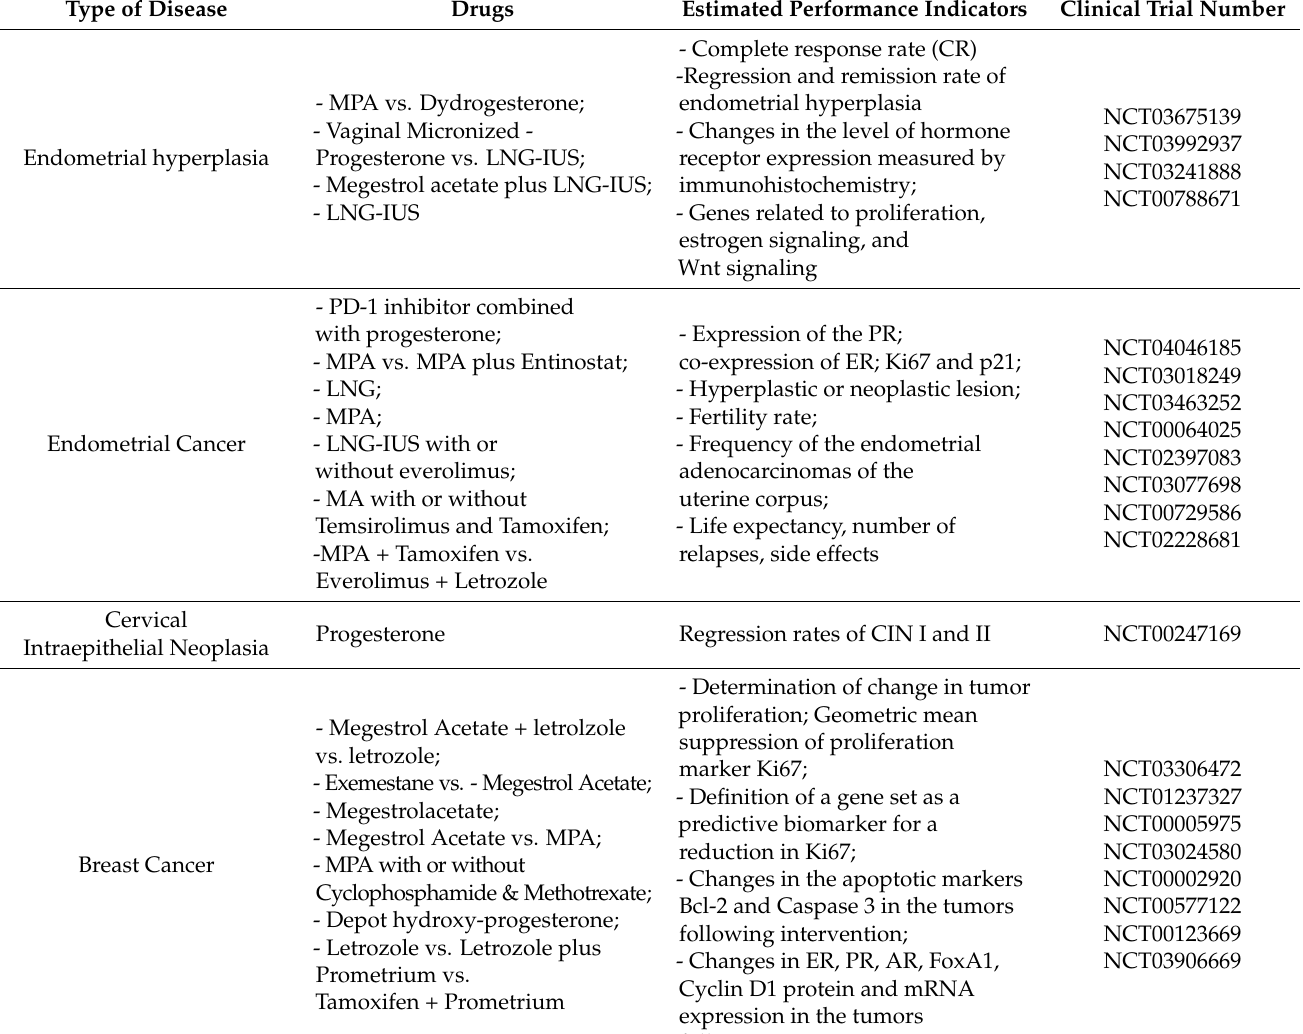
Table 2. Completed and ongoing clinical trials of progestogens in endometrial hyperplasia, endometrial cancer, and breast